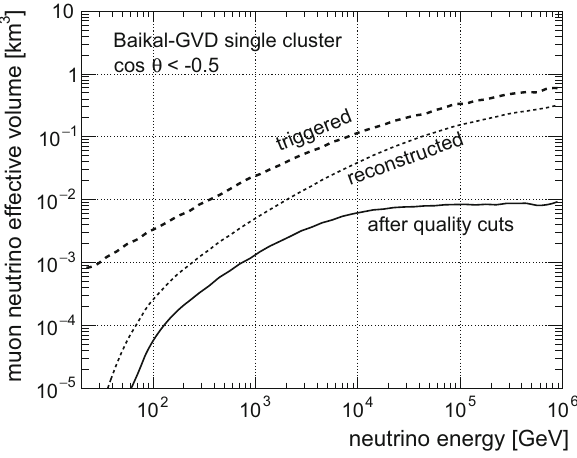
Fig. 5 Effective volume of a standard Baikal-GVD cluster for muon neutrino CC interactions at trigger level (thick dashed line), at recon- struction level using the χ 2 -based reconstruction (thin dashed line), and after the event selection cuts optimized for the atmospheric neu- trinospectrum(solidline).Shownaretheaveragecurvesoverthezenith angle range θ > 120 ◦ (upward-going)